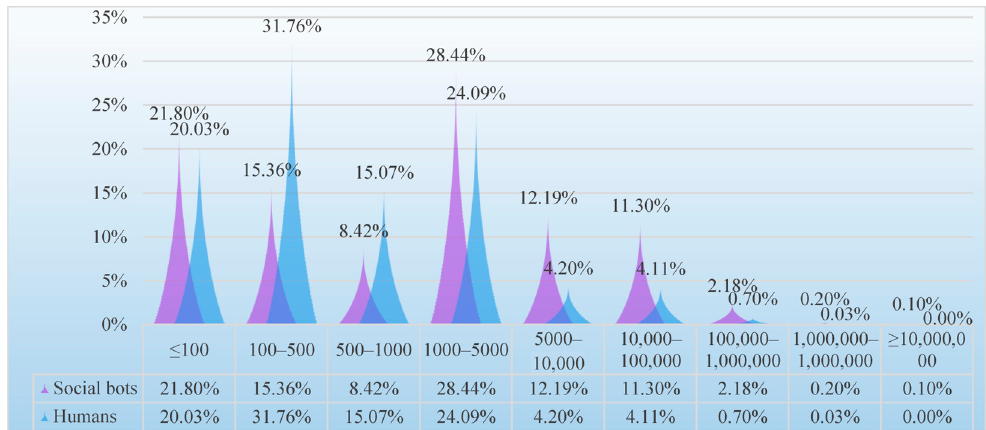
Figure 11. Distribution of the number of followers of social bots and humans.